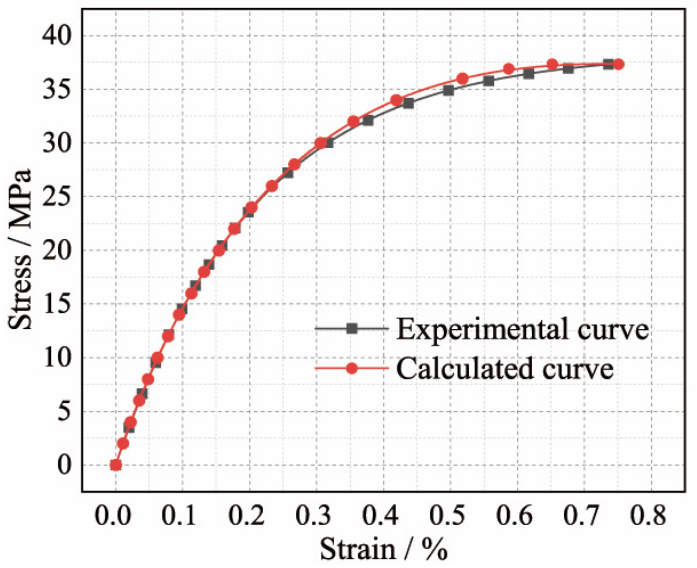
Figure 11. The comparison between the experimental compressive stress–strain curves and the calculated compressive stress–strain curves of the SCC.